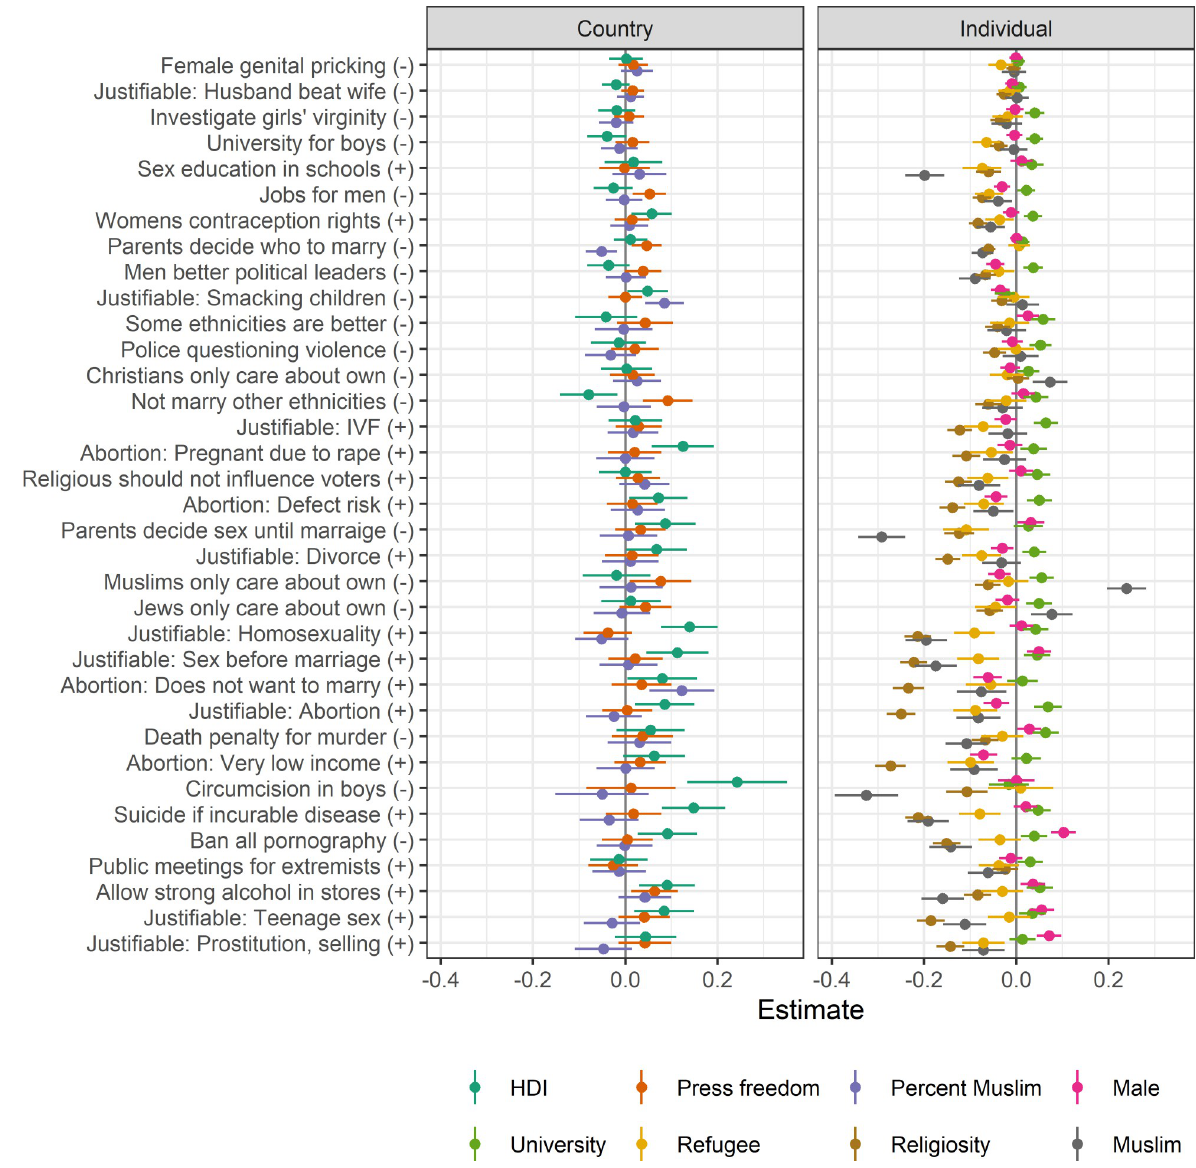
Fig 2. Effects of country-of-origin and individual variables on the social values of immigrants. Full results in S3 Table.